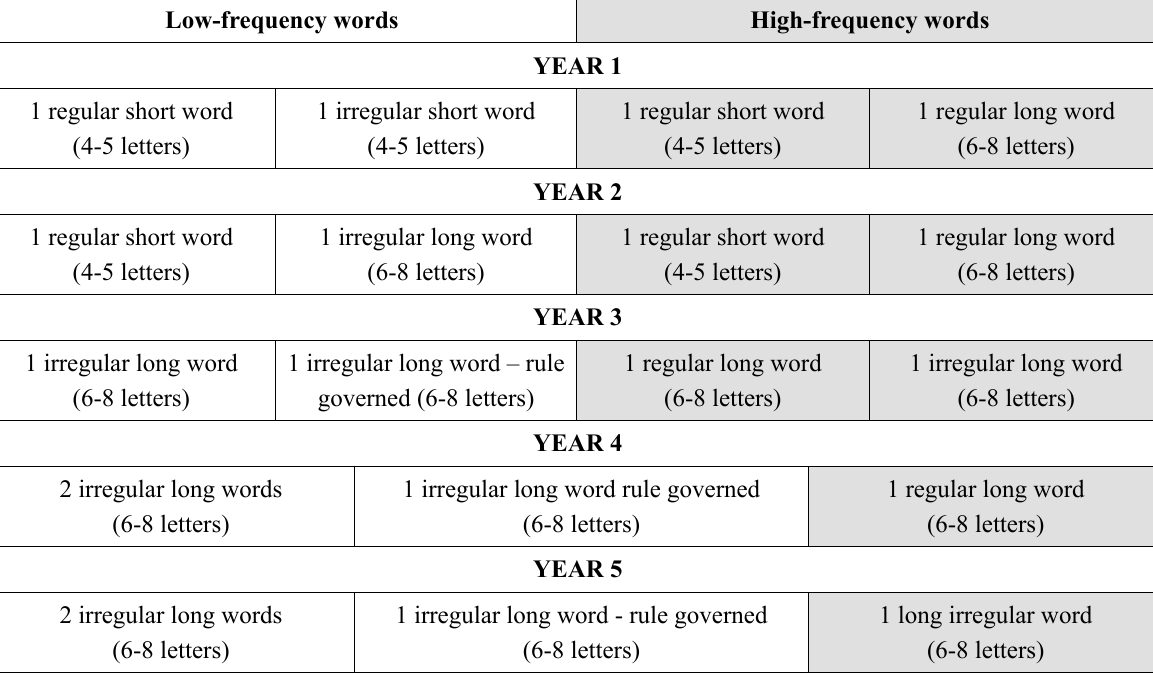
Figure 1 . Distribution of criteria for selecting words ( n = 20) for each word decision subtest form, based on frequency in Portuguese language and school